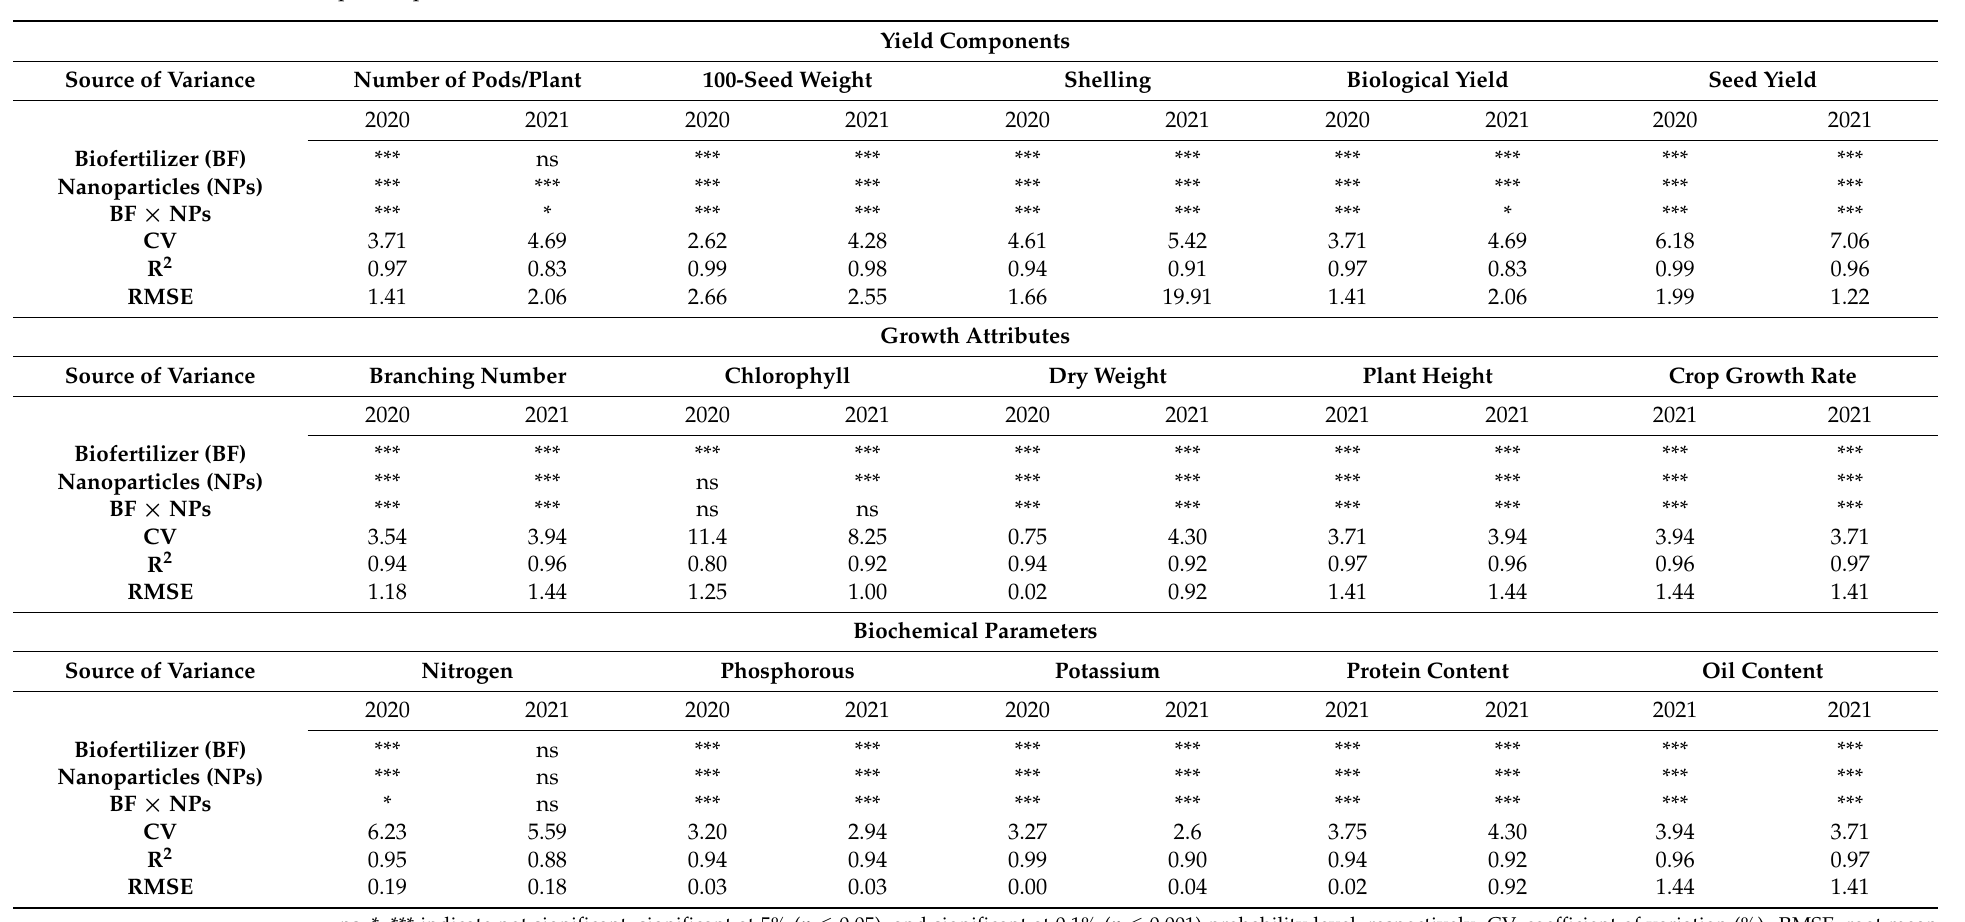
Table 1. ANOVA of the effects of biofertilizers, nanoparticles applications, and their interaction on growth, physiological, yield, and biochemical parameters of peanut